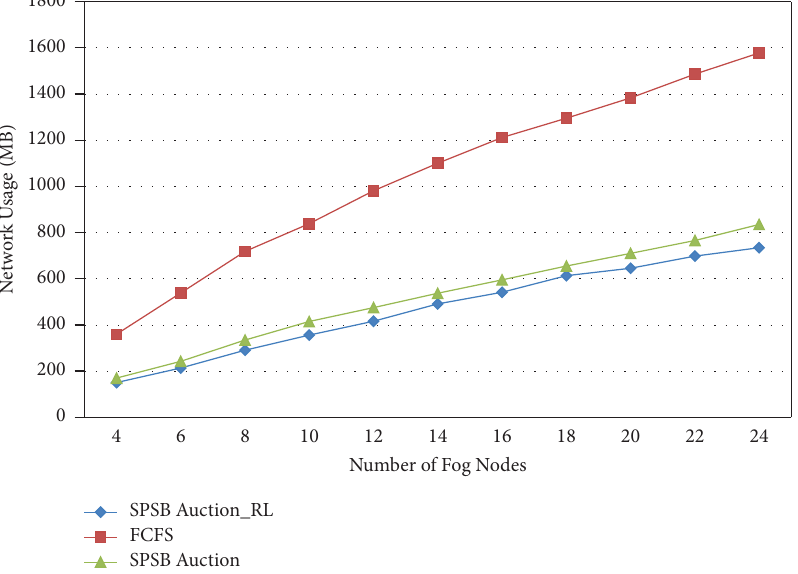
Figure 10: Network usage for diferent numbers of fog nodes.